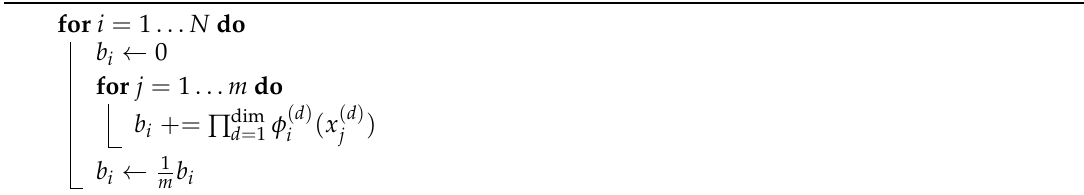
Algorithm 1: The streaming algorithm for computing the right-hand side b for i = 1 . . . N